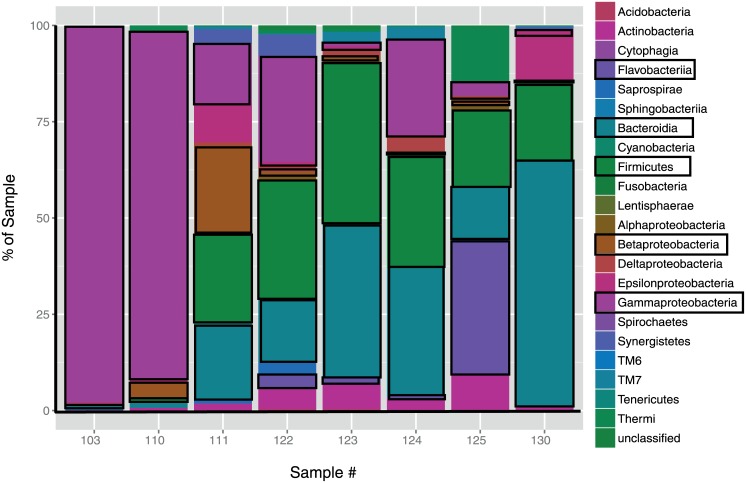
Bacterial abundance present in the cloaca of Agkistrodon piscivorus.Relative abundance of bacterial lineages found in cloacal samples of Agkistrodon piscivorus individuals (numbered) as identified 16S rRNA gene pyrosequencing. Abundances are based on proportional number of 454 reads (from 839–2919) total reads per sample). Major bacterial groups are outlined by black boxes.